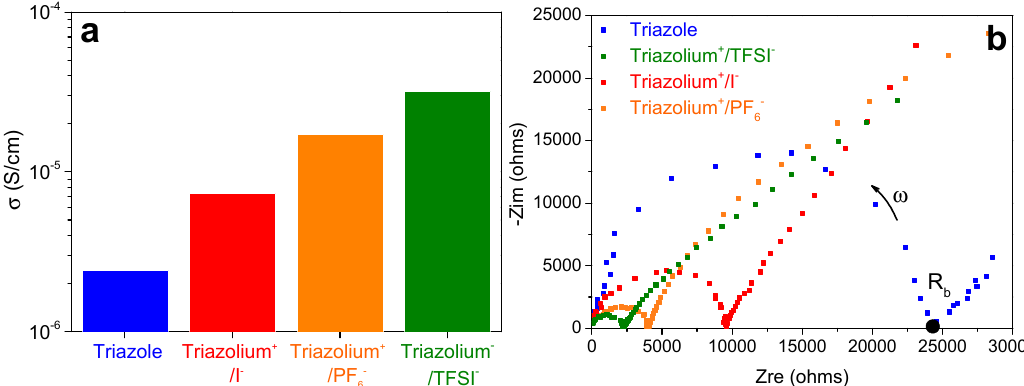
Figure5. ( a )Conductivityvaluesand( b )Nyquistdiagramofeachgelcomprising2.4mol%ofcrosslinker Figure 5. ( a ) Conductivity values and ( b ) Nyquist diagram of each gel comprising 2.4 mol % of and swollen with EC / DEC (1 / 1). The measurements were carried out at ambient temperature, on cells crosslinker and swollen with EC/DEC (1/1). The measurements were carried out at ambient composed of Stainless Steel | PTMA gel | Stainless temperature, on cells composed of Stainless Steel|PTMA gel|Stainless Steel.